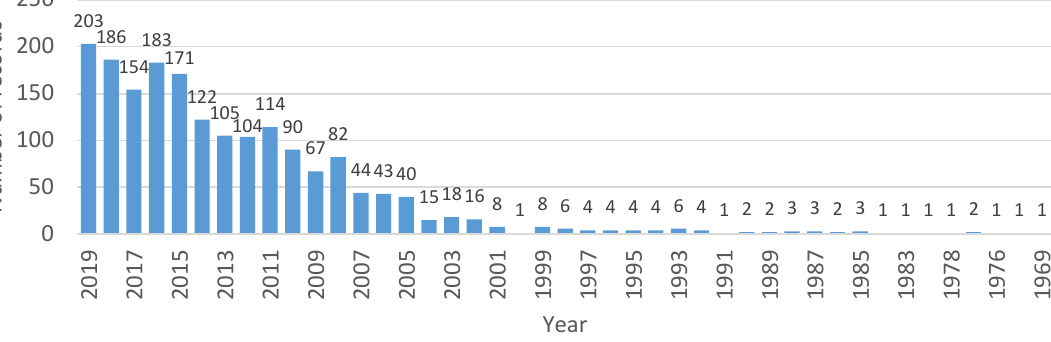
Figure 2. Number of publications with the term “Earnings Management” in Web of